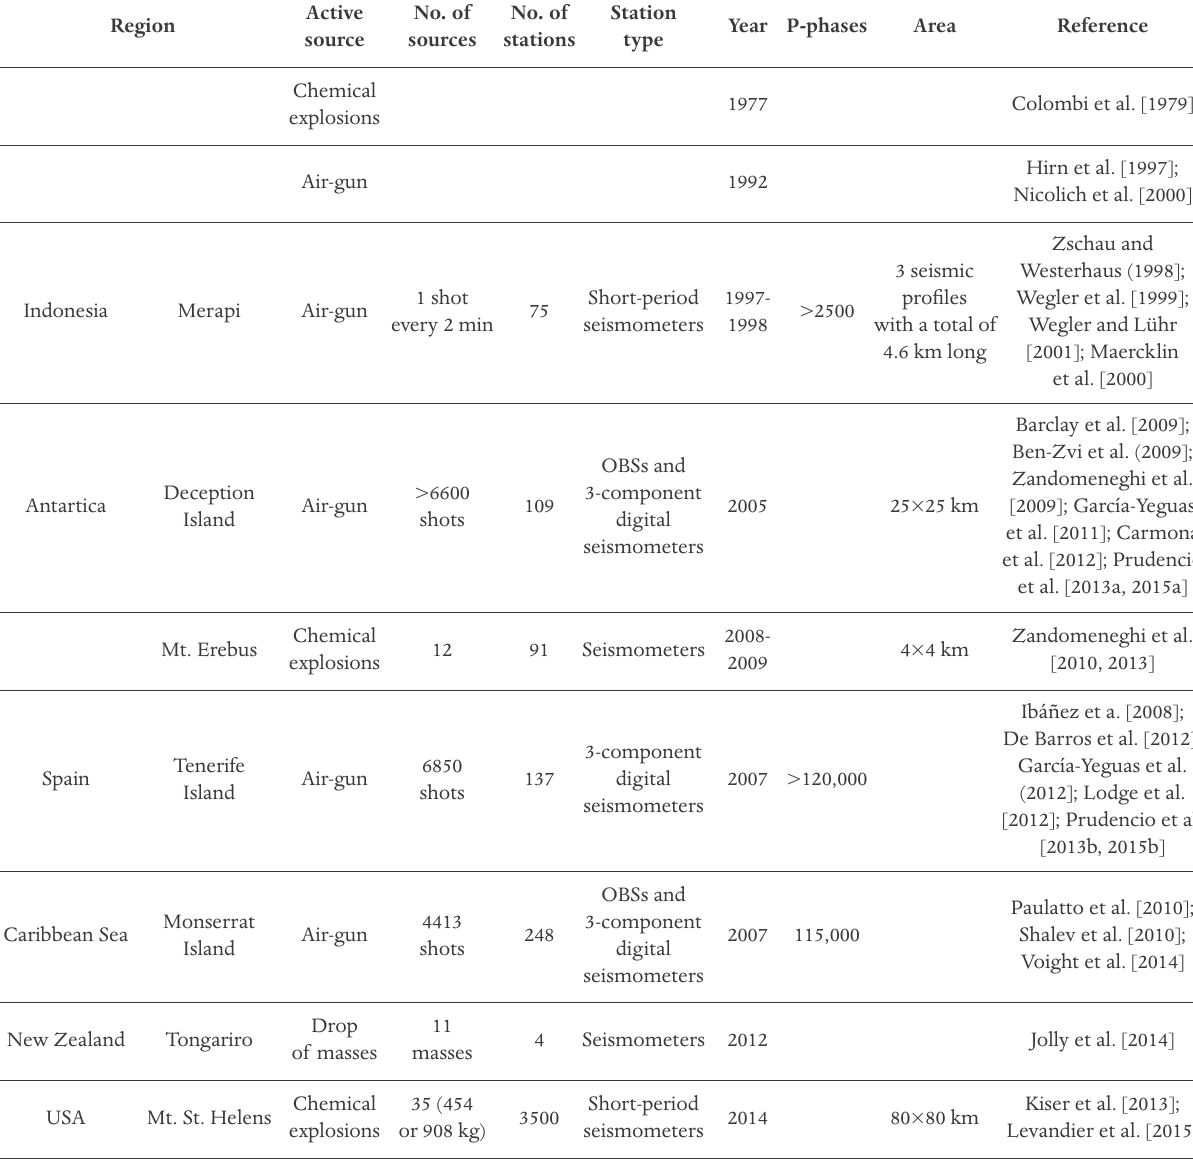
Table 1 (continues from previous page). Brief summary of the most important active seismic experiment performed over the world during the las 20